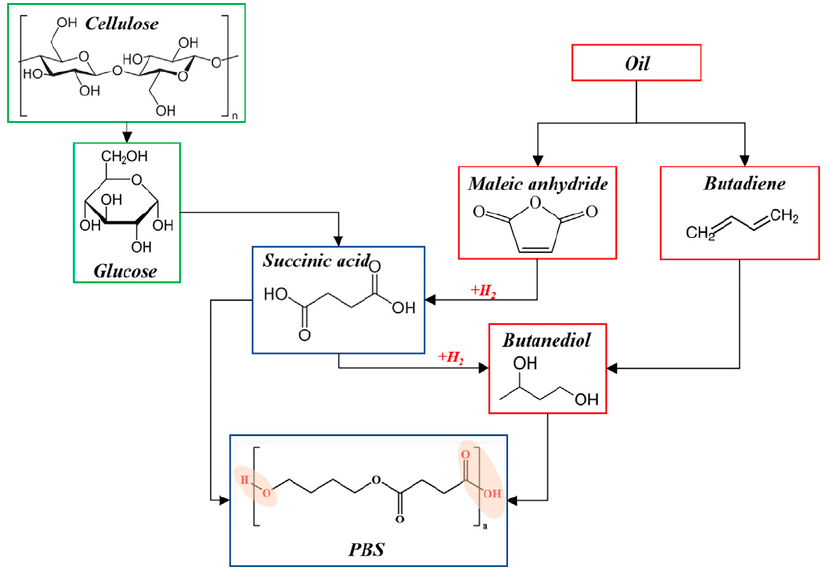
Figure 1. Flowchart of PBS synthesis via bio- or fossil-based sources. Reprinted with permission from [26]. Copyright 2022 Elsevier.